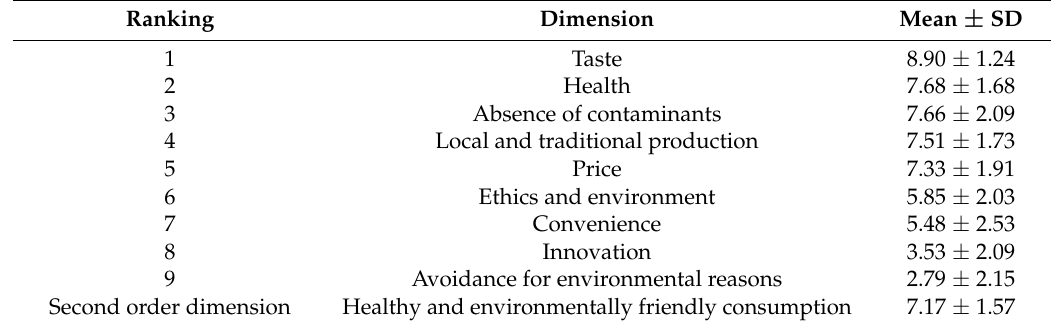
Table 4. Mean food choice motive dimension scores (scores ranging from 0 to 10), NutriNet-Santé Study, n = 22,966 1